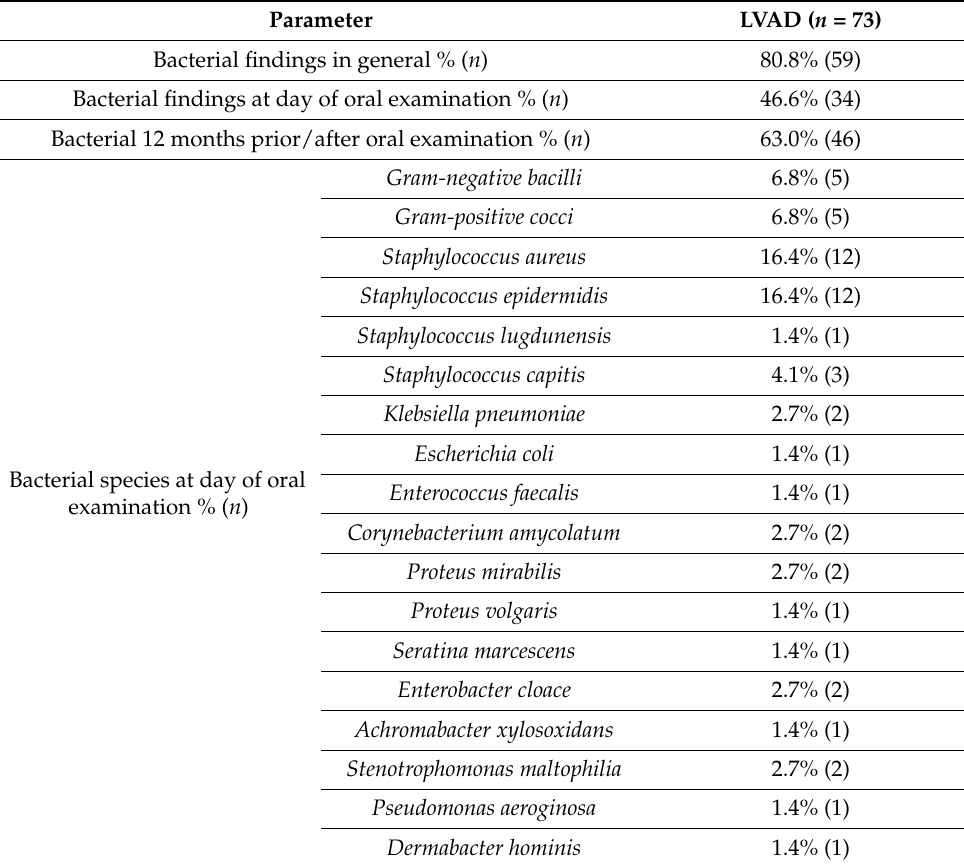
Table 2. Microbiological findings of LVAD patients.